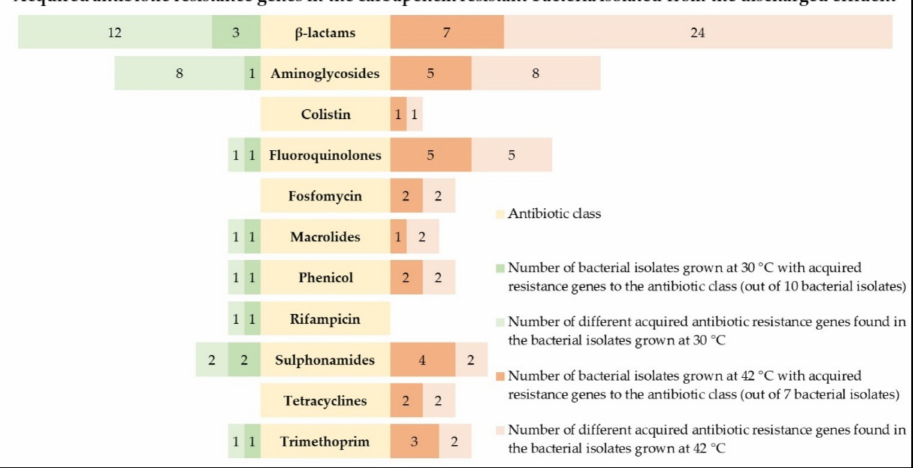
Figure 1. Number of bacterial isolates grown at 30 ◦ C (green) and 42 ◦ C (orange) from the discharged effluent samples harbouring acquired resistance genes towards different AB classes (yellow) and corresponding diversity of acquired AB resistance genes (light green and light